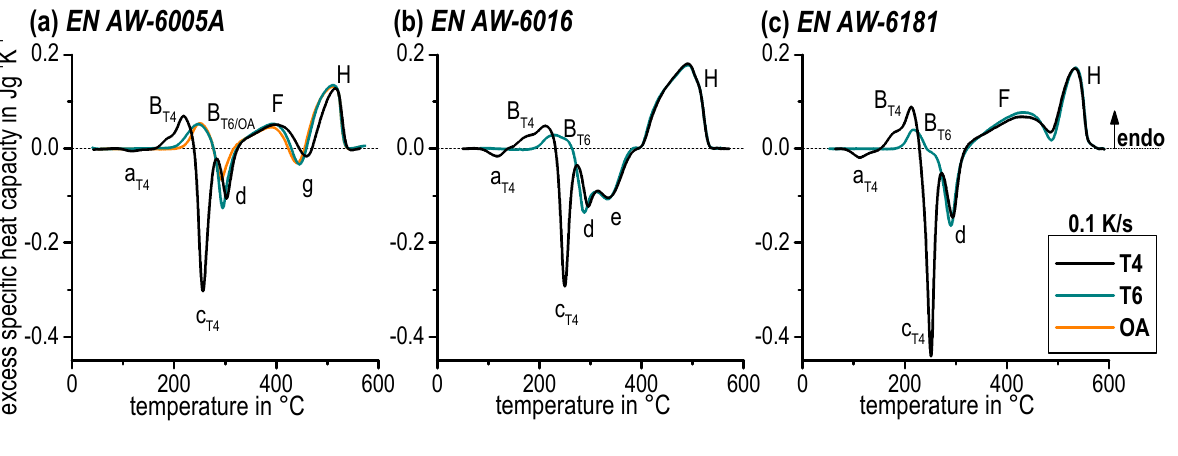
Figure 5. Continuous heating DSC curves at 0.1 K/s for various initial conditions ( a ) EN AW-6005A – T4, T6 and OA. ( b ) EN AW-6016 T4 and T6. ( c ) EN AW-6181 T4 and